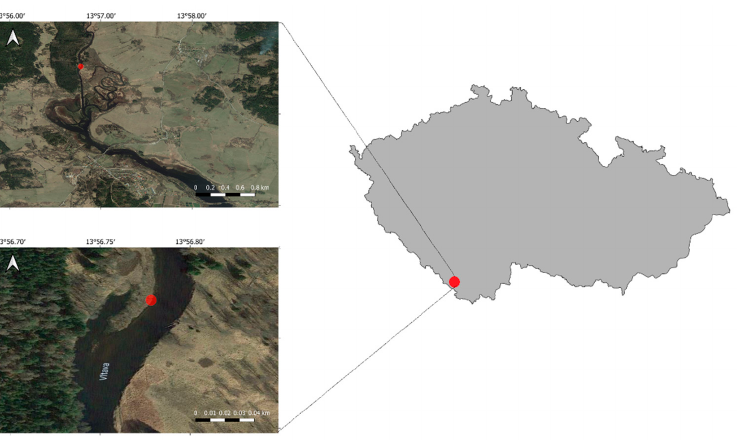
Figure 1. The site studied for monitoring fish upstream migration was located on the Vltava River, Czech Republic, approximately 2 km upstream off the Lipno reservoir (upper enlargement) and the DIDSON acoustic camera was placed on the right bank of the river (lower enlargement).